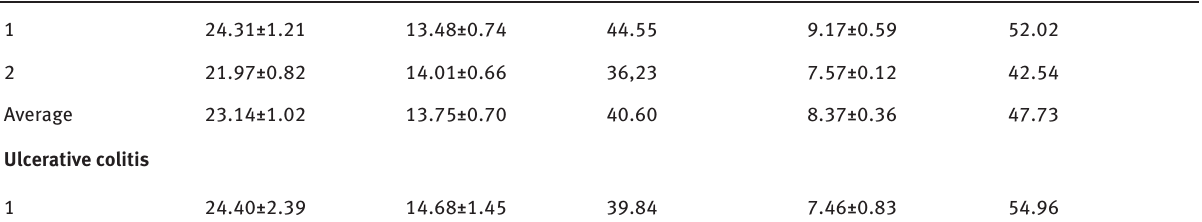
SRB suspension from mice Number of